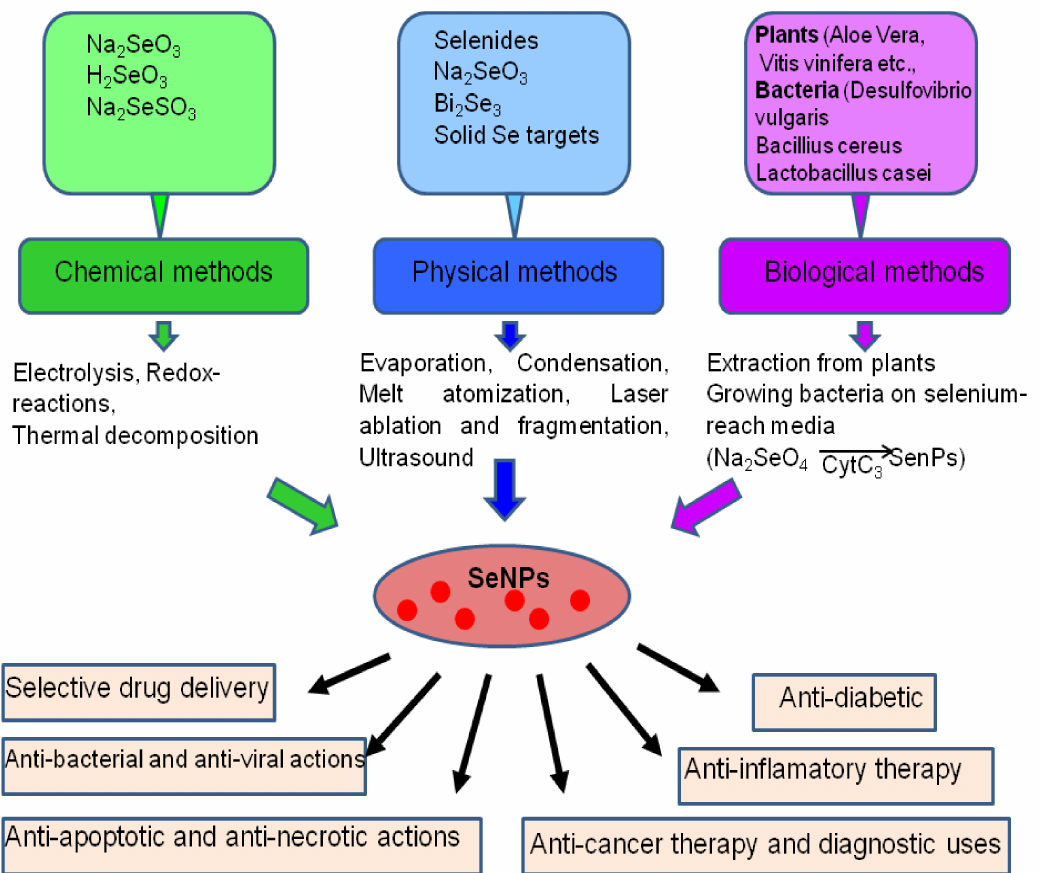
Figure 1. Methods for obtaining SeNPs and their